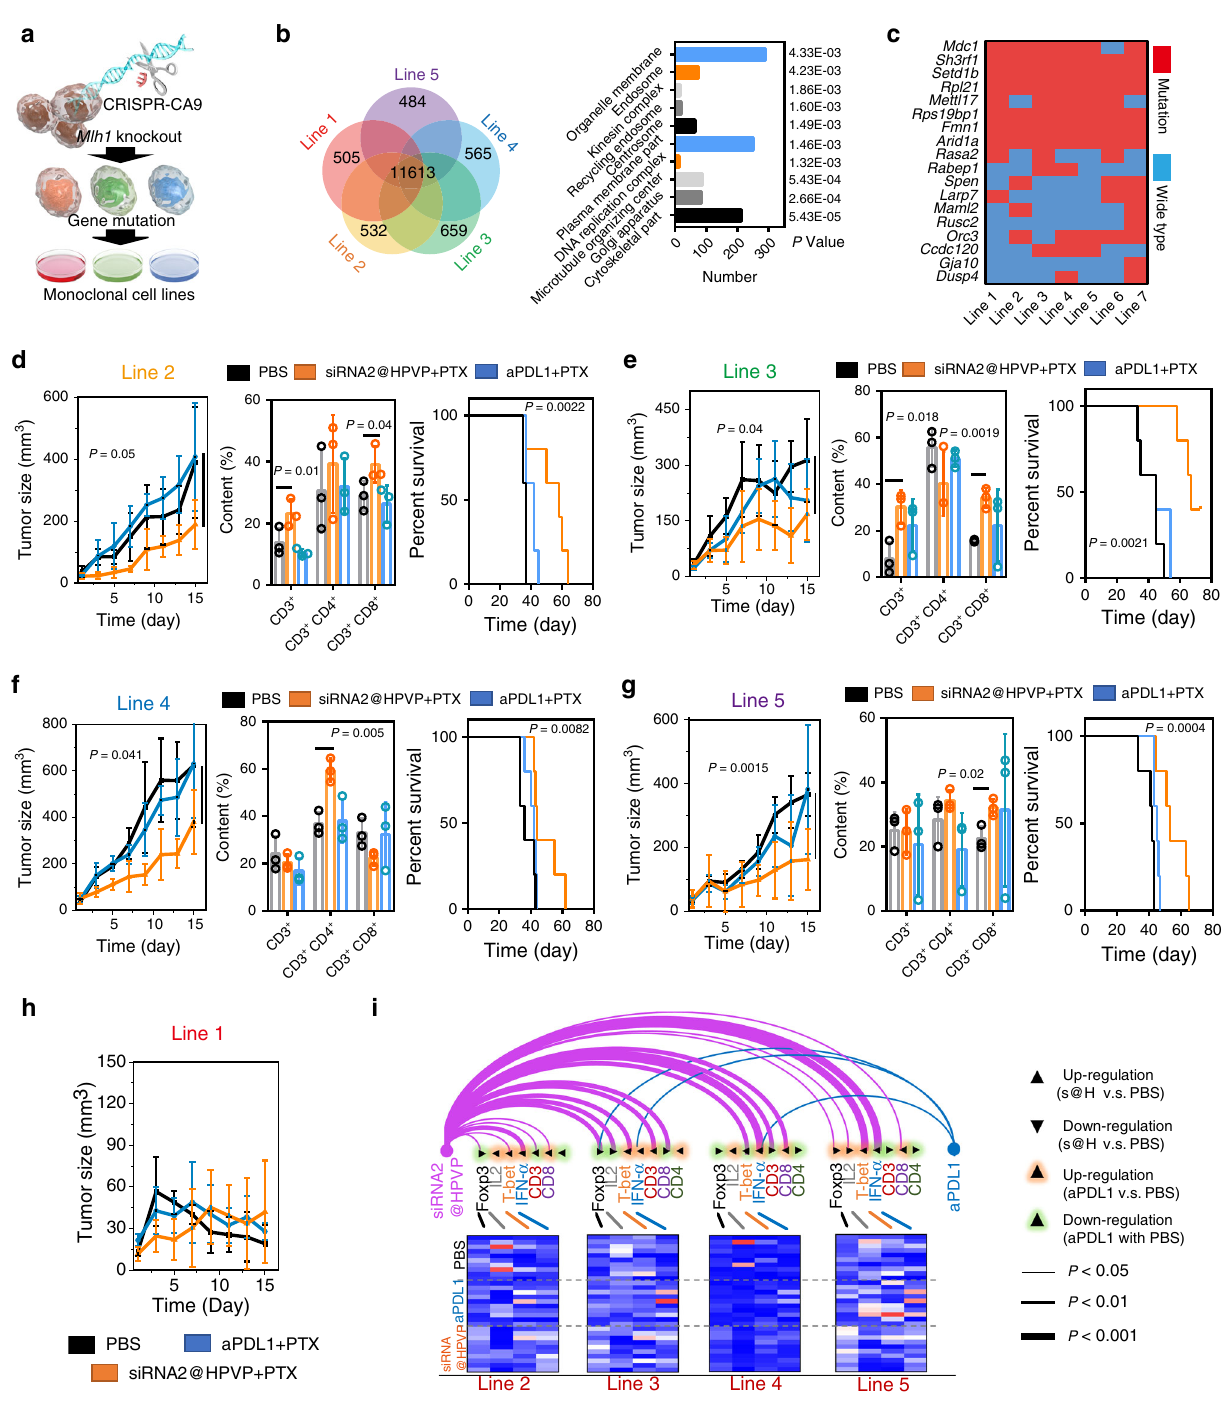
Fig. 6 The therapeutic response rate of siRNA2@HPVP treatment. a Schematic illustration of the CRISPR-Cas9-mediated Mlh1 knockout for large-scale gene mutations. Seven monoclonal 4T1 cell lines with different gene mutations were puri fi ed. Five cell lines were respectively inoculated on the mice to evaluate the immune response rate of siRNA2@HPVP treatment. b SNP (left) and Indel (right) analyses of the obtained seven mutant cell lines. The union graph of total mutation among fi ve mutant cell lines was constructed to evaluate the connection between the fi ve cell lines. c AS analysis of the mutation of the cell lines after Mlh1 knockout. d – h Tumor growth curves (left, fi ve biological replicates are shown), tumor-in fi ltrating T cells proportions (middle, three biological replicates are shown) and survival curves (right, fi ve biological replicates are shown) of fi ve distinct breast tumor models with aPDL1 plus PTX (1 mg kg − 1 aPDL1 and 10 mg kg − 1 PTX) or siRNA2@HPVP plus PTX (7.5 mg kg − 1 siRNA2@HPVP and 10 mg kg − 1 PTX) treatment by i.v . injection ( n = 5 per group). Three tumors per group were collected for fl ow cytometry analysis. i Arc plot and heat map for illustrating the intratumoral immune indexes (CD3, CD4, CD8, Foxp3, IL2, T-bet, and IFN- γ ) in each individual. Two locations were taken for each tumor. Statistical signi fi cance was calculated via two-tailed Student ’ s t test ( b , d – g , i ) and Logrank test (two-sided) for trend ( d – g ). Data are presented as mean values ±